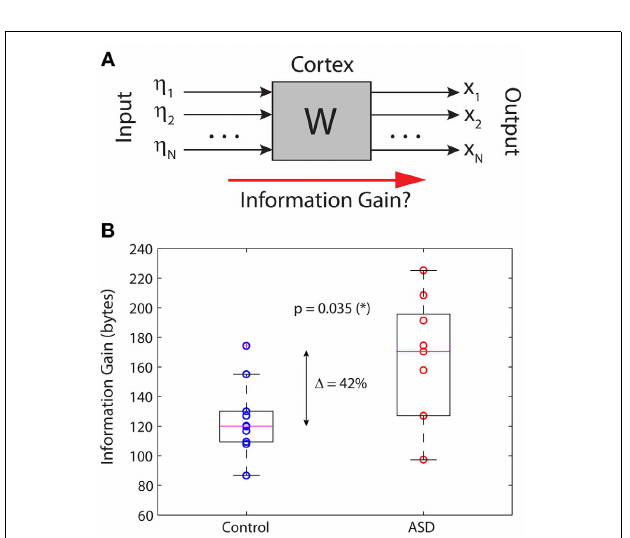
FIGURE 4 | Information gain in the brain’s resting state. (A) Schematic black-box representation of cortical dynamics in the resting state. (B) The information gain is significantly increased by 42% in autistic relative to non-autistic children.